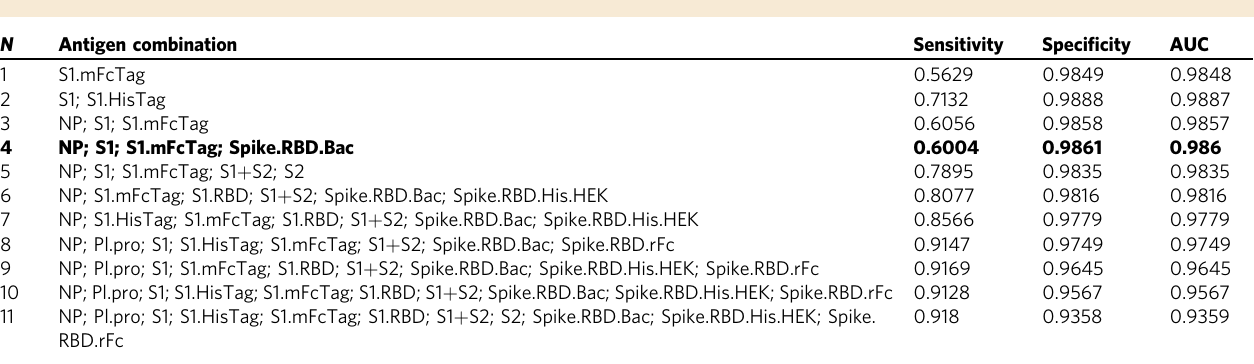
Table 3 Ranking of high-performing SARS-CoV-2 antigen combinations for